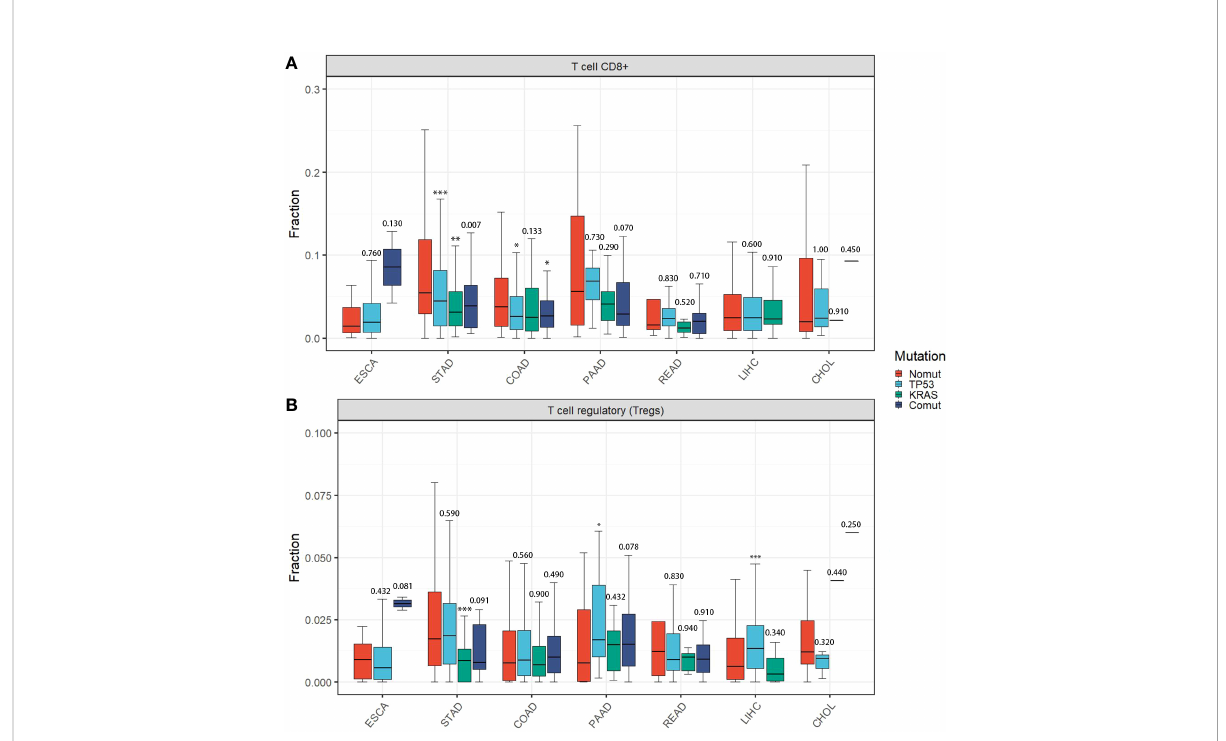
FIGURE 2 Immune cell in fi ltration among different TP53/KRAS mutation groups in gastrointestinal tumors. (A) T cell CD8+. (B) T cell regulatory (Tregs). P- values represented TP53/KRAS mutation groups compared to non-mutant group. (Wilcox test. *, P < 0.05; **, P < 0.01; ***, P <